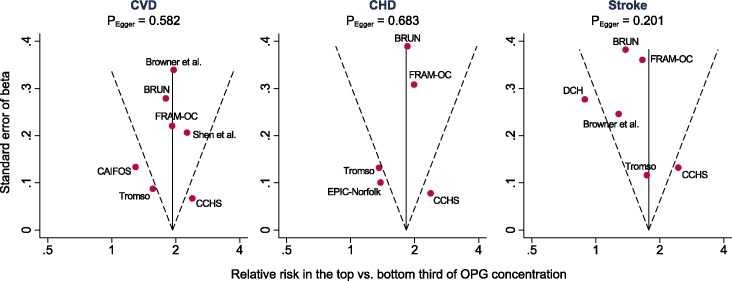
Funnel plots of reported associations between osteoprotegerin and risk of cardiovascular outcomes.Full study names are listed in the footnote of Table 2. The dotted lines show pseudo 95% confidence intervals around the overall pooled estimate. P values are from Egger’s asymmetry test of associations.